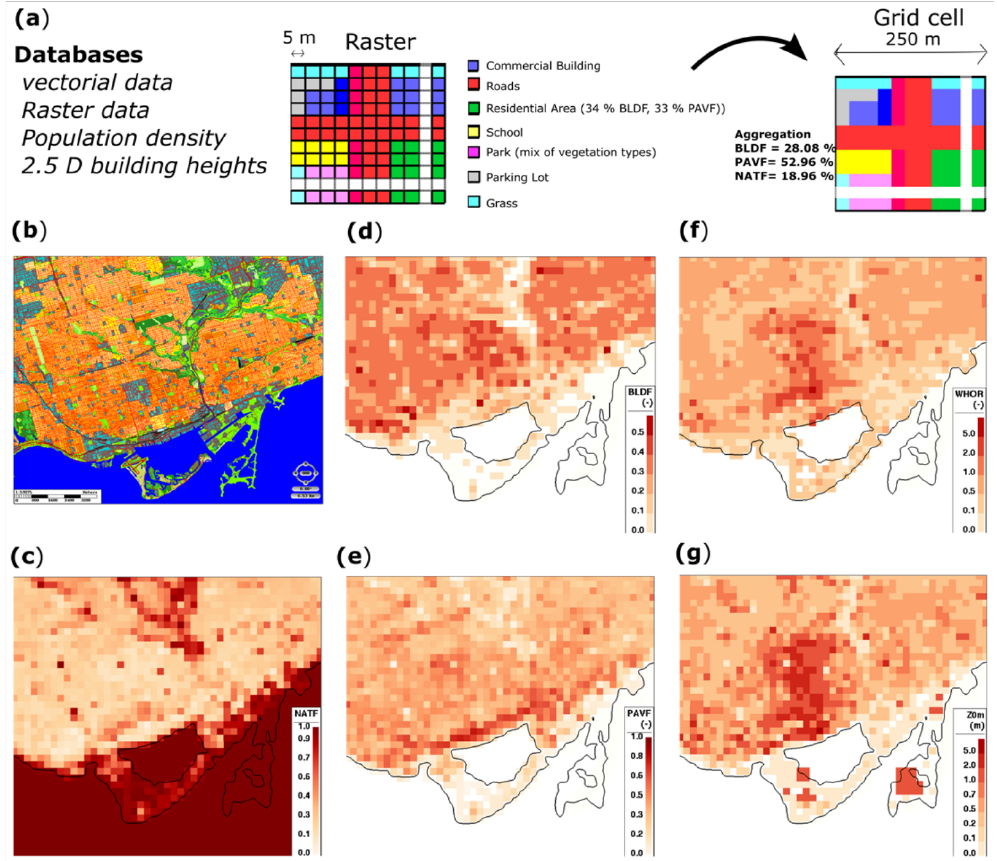
Figure 2. Sketch of the method for obtaining the urban description ( a ), and sample region of the downtown Toronto for an intermediate classification with 5-m grid spacing ( b ), and results with 250-m grid spacing for fraction of natural areas including water ( c ), fraction of buildings ( d ), fraction of artificial impervious area ( e ), the vertical to horizontal surfaces ratio ( f ), and aerodynamic roughness length (in m) ( g ). Note that in ( a ), the white areas represent missing pixels that are not represented for the sake of